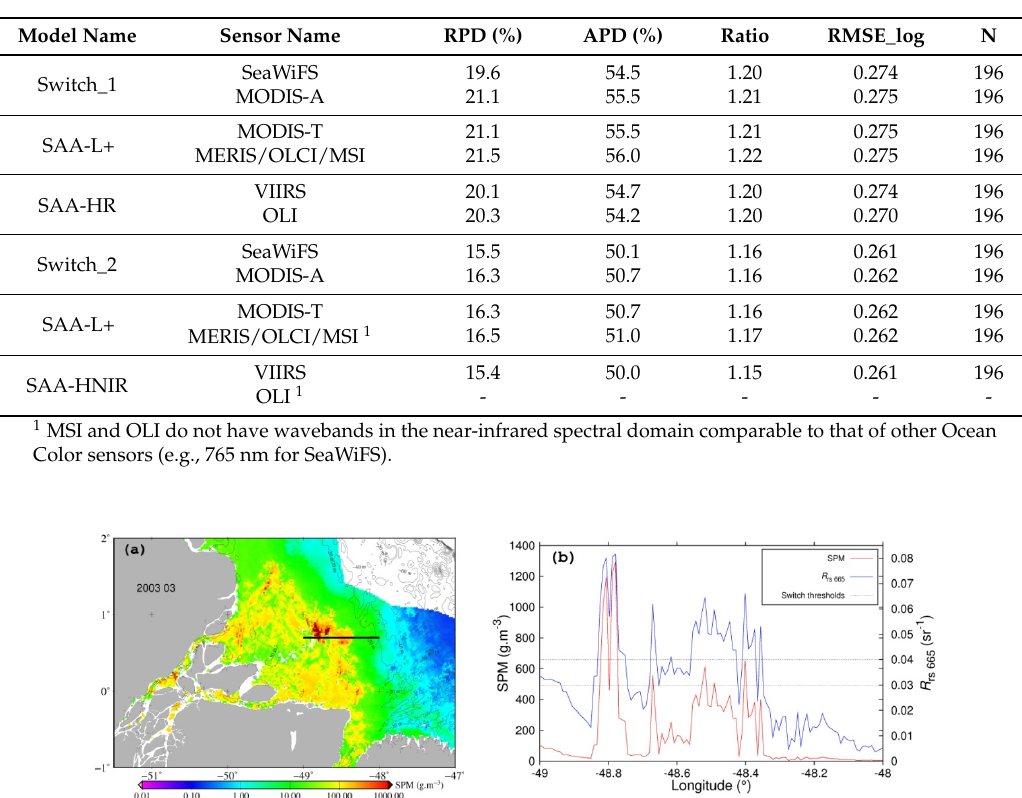
Table 7. Performance of combined SPM -dependent models for various ocean color sensors on DS-V.